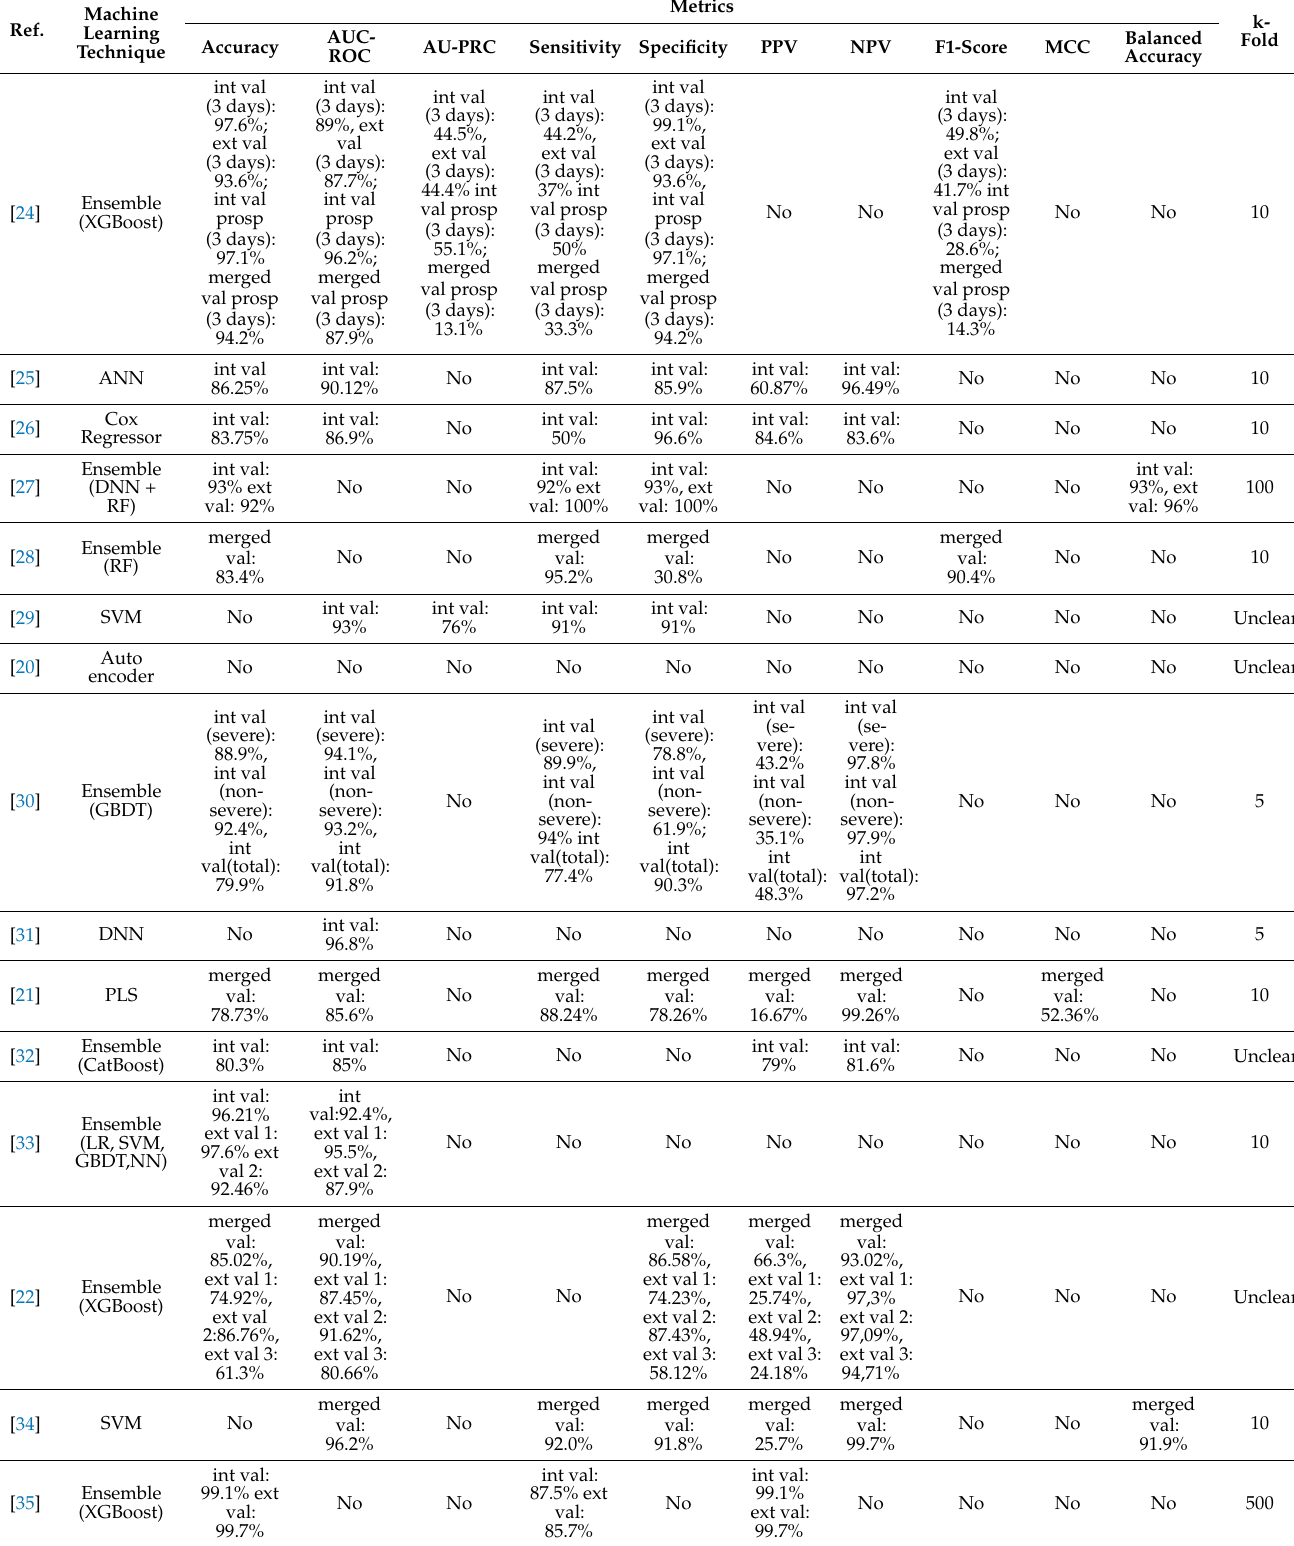
Table 3. Best performing methods and metrics results. Abbreviations: XGBoost, Extreme Gradient Boosting; ANN, Artificial Neural Network; DNN, Dense Neural Network; RF, Random Forest; SVM, Support Vector Machine; GBDT, Gradient Boosting Decision Tree; PLS, partial least square; LR, Logistic Regressor; NN, Neural Network; MLP, Multi-Layer Perceptron; LightGBM, Light Gradient Boosting Machine. No Not Included in the study. Machine Ref.